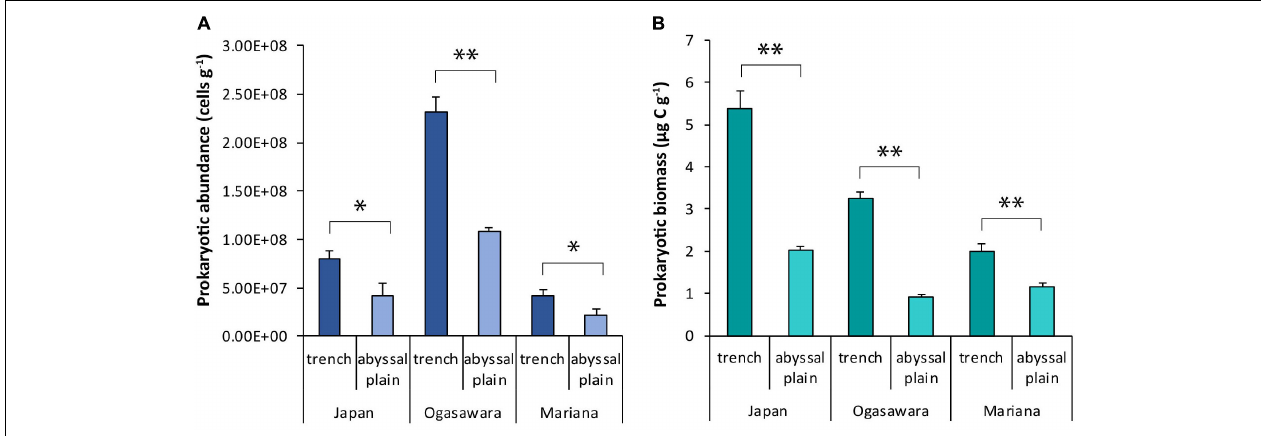
FIGURE 2 | (A) Prokaryotic abundance and (B) prokaryotic biomass. Reported are the mean values and related SDs for each hadal trench and related abyssal site. Statistical significance is tested between hadal trench sites and abyssal sites. ∗ p < 0.05, ∗∗ p < 0.01.